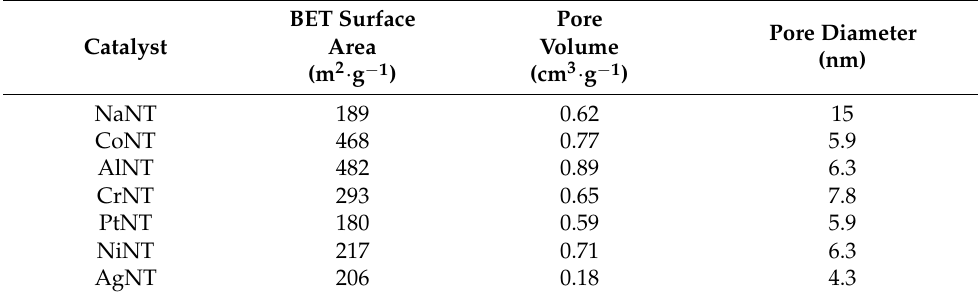
Table 2. Textural properties determined from the nitrogen physisorption isotherms for the catalysts